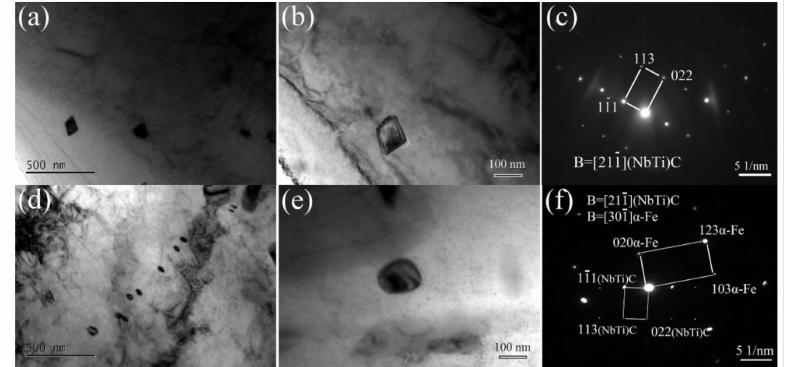
Figure 4. TEM images of cast steel D: ( a , b ) precipitated particles; ( c ) selected-area diffraction pattern (SADP) of square particles in ( b ); ( d , e ) added particles; ( f ) the SADP of the elliptical particle in ( e